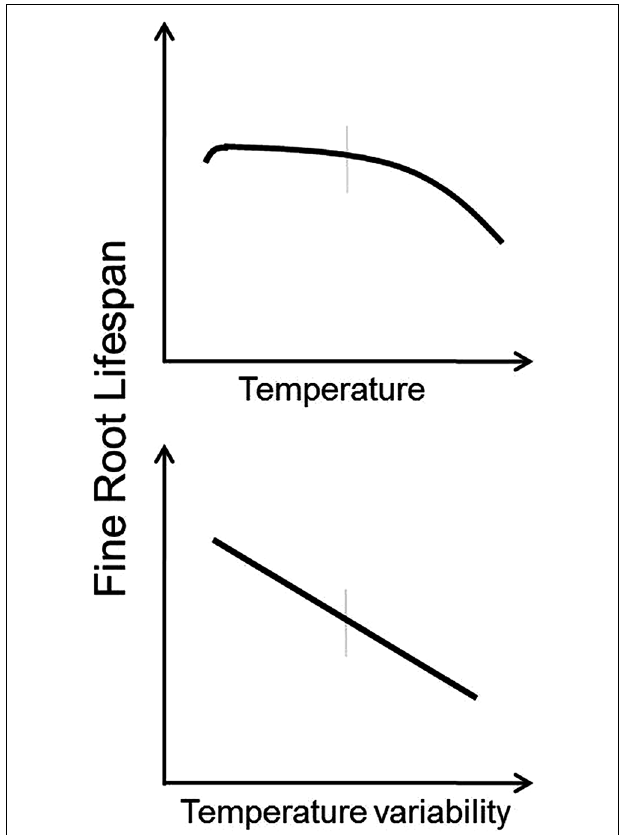
FIGURE 2 | Conceptual models indicating predicted responses of fine root lifespan to increased temperature (top panel) and increased temperature variability (bottom panel). Vertical gray bars indicate “average” conditions experienced by a given species across its native range.